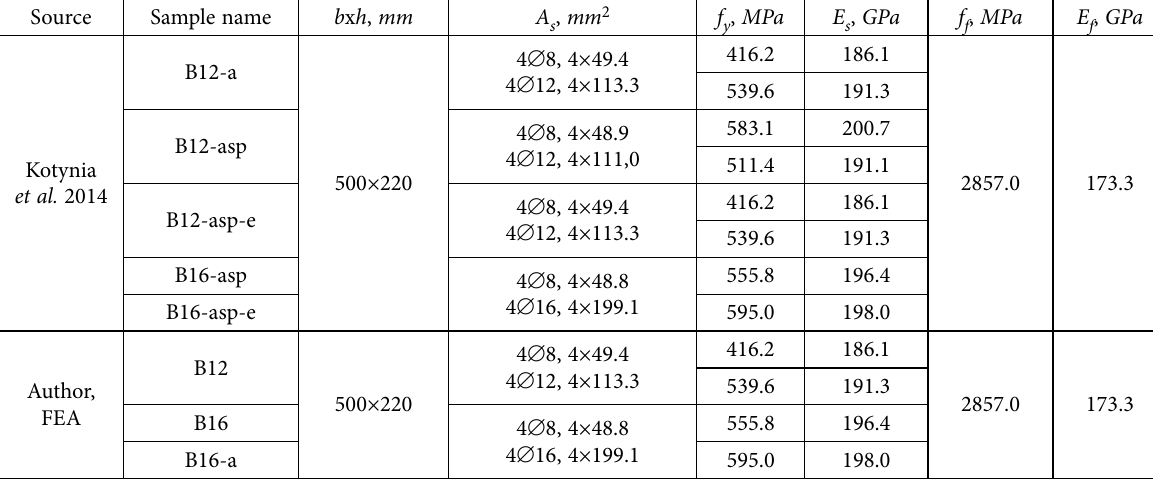
Table 1. List of analyzed beams and mechanical parameters of reinforcement